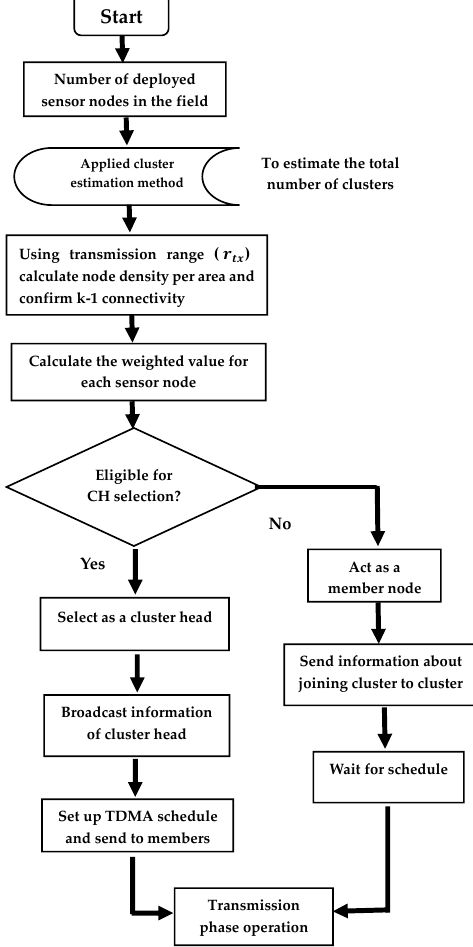
Figure 3. Flowchart of cluster head selection and cluster formation in the CWCA algorithm .